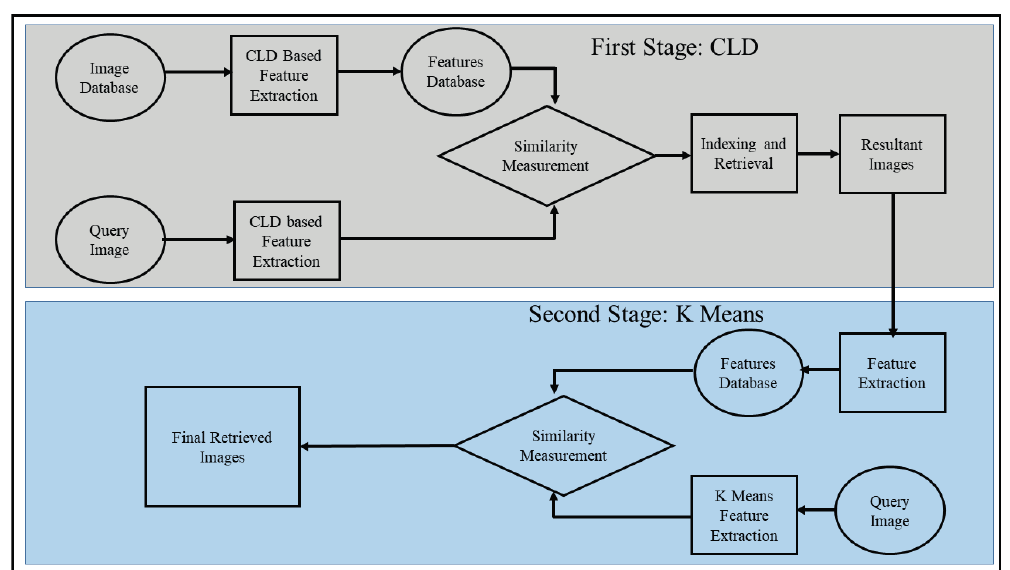
Fig. 5. CLD and K-Means based